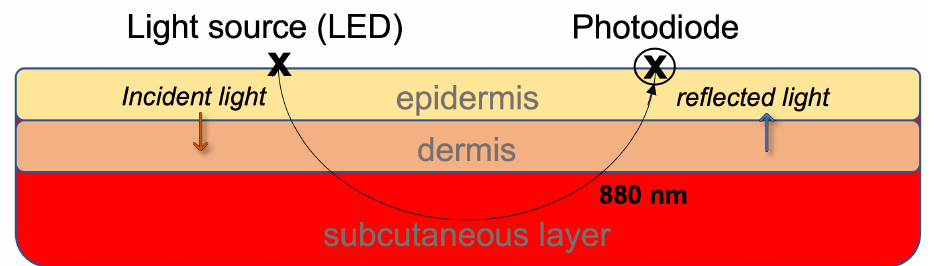
Figure 1. The principle of light reflectance and absorption through the different layers of the skin.